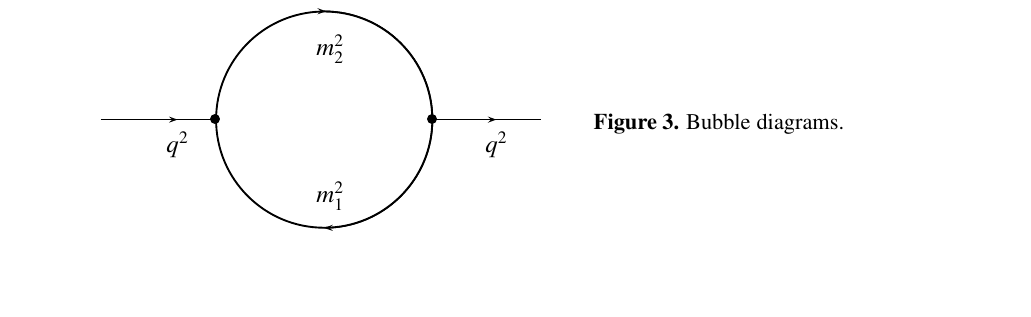
Figure 3. Bubble